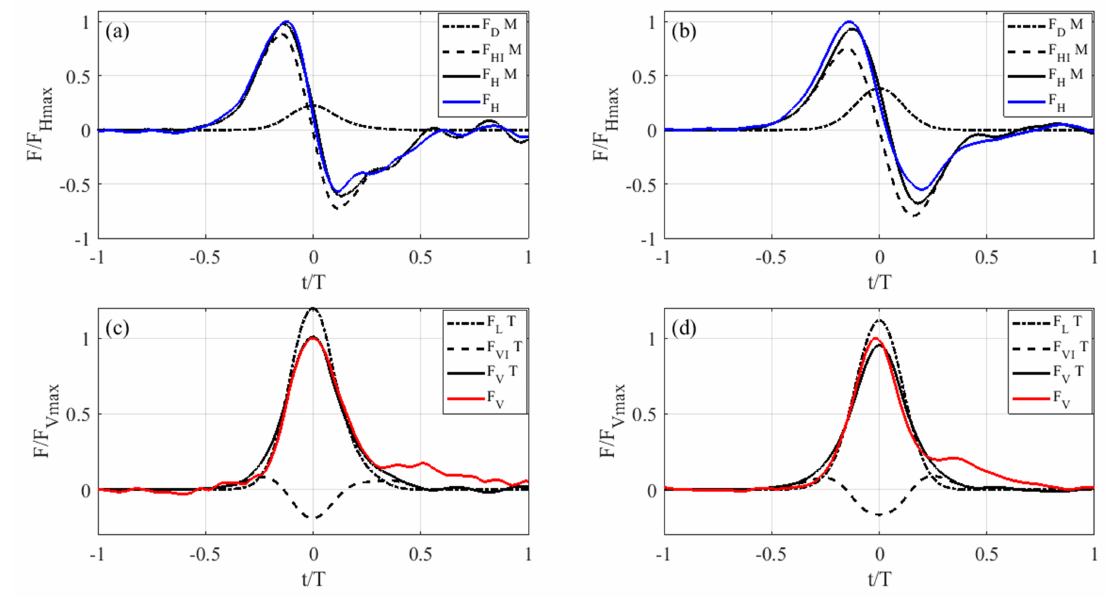
Figure 10. Time history of hydrodynamic loads determined by semi-empirical formulas and experiments. ( a ) Comparison between Morison F D M , F HI M , and F H M calibrated by experiments and experimental F H (test number 5); ( b ) Comparison between Morison F D M , F HI M , and F H M calibrated by experiments and experimental F H (test number 30); ( c ) Comparison between transverse F L T , F VI T , and F V T calibrated by experiments and experimental F V (test number 5); ( d ) Comparison between transverse F L T , F VI T , and F V T calibrated by experiments and experimental F V (test number 30).